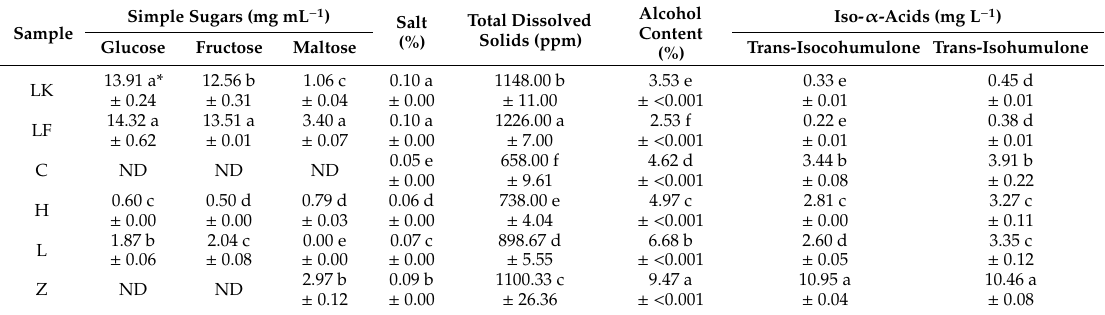
* Values represent the mean ± standard error (n Simplesugars,Iso- α -acids = 2, n Salt,Totaldissolvedsolids,Ethanolcontent = 3). ND: Non-detectable. Abbreviations of samples may be found in Table 1. Di ff erent letters within a column indicate that values are significantly di ff erent according to the least significant di ff erence test (LSD; p < 0.05).